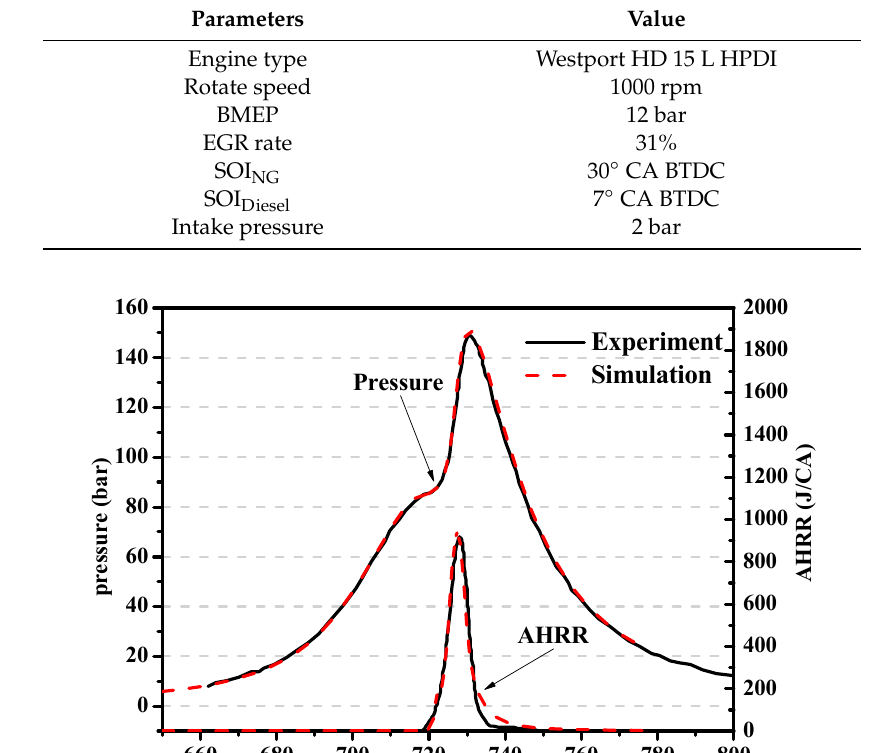
Figure 3. Verification of wall-impinging jet model at different moments.